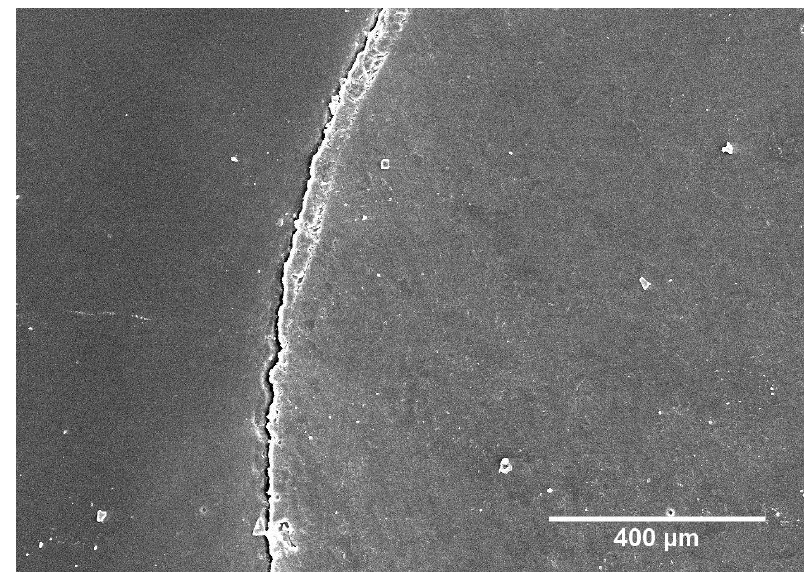
Figure 3. SEM micrograph of non-continuous margin (group 1; iBond Self Etch without phosphoric acid etching in demineralized enamel).